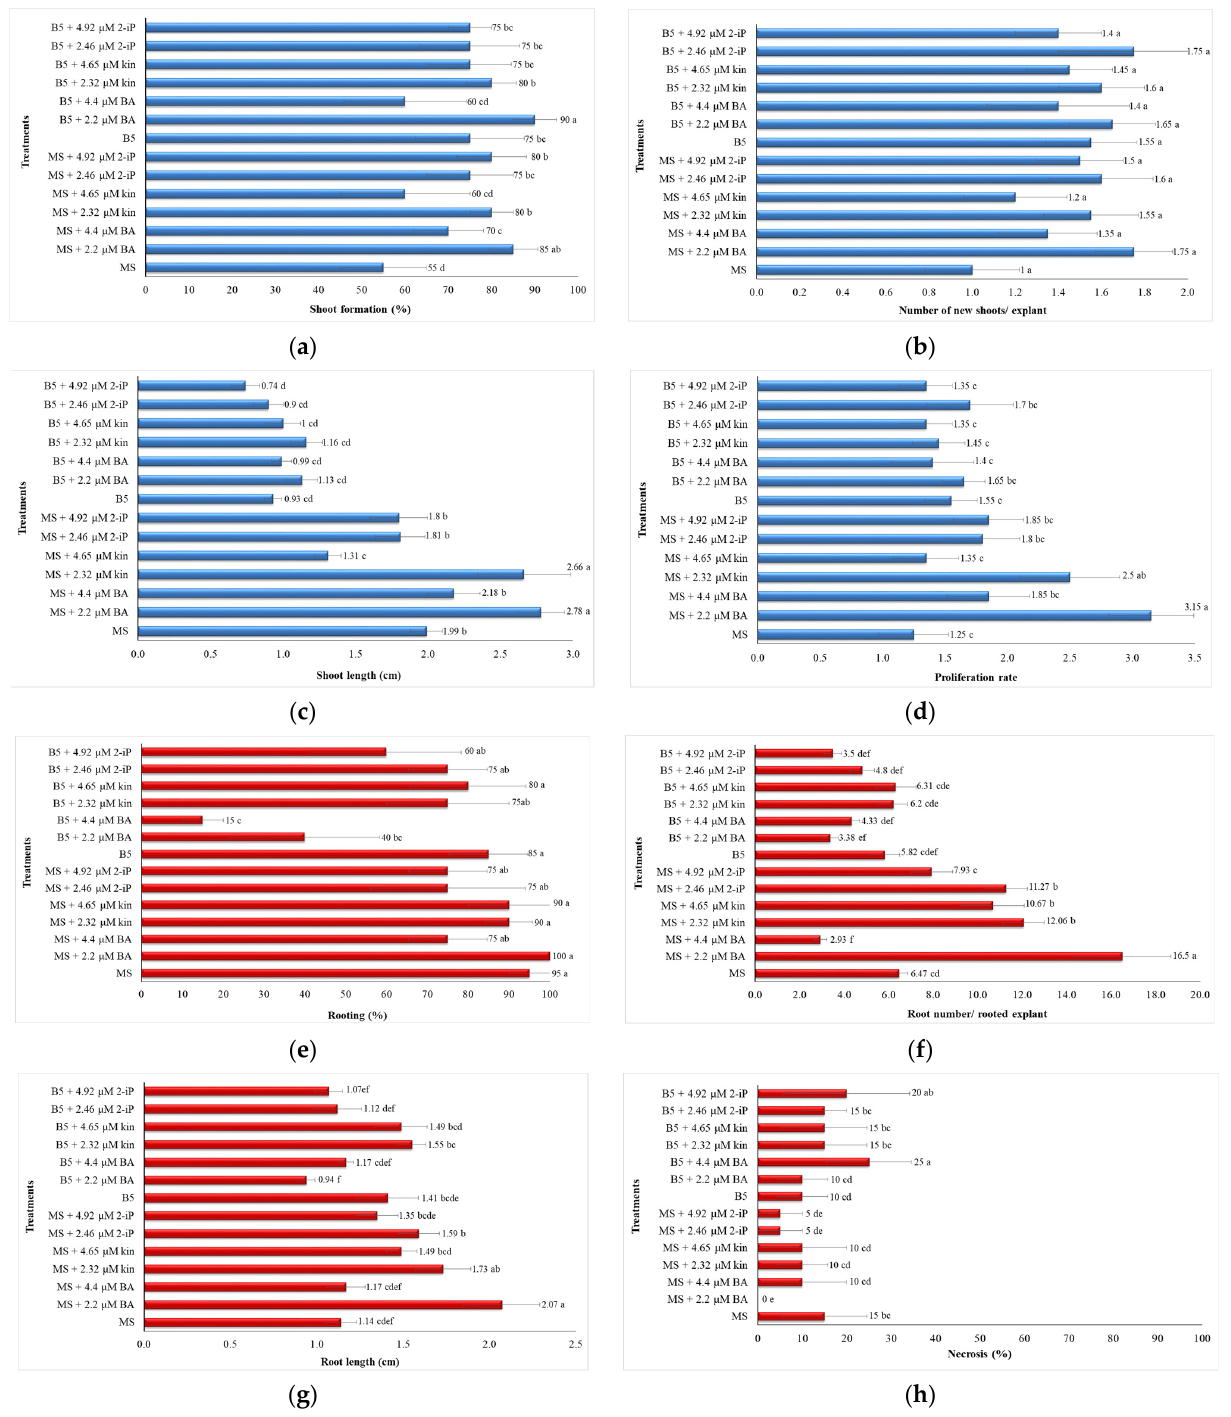
Figure 1. Effect of two basal culture media (MS, B5) supplemented with 0.25 μ M IBA, 0.3 μ M GA 3 , 20 g L − 1 sucrose and 6 g L − 1 Plant Agar (pH: 5.8) in combination with three cytokinin types (BA, Kin, 2-iP) at three concentrations on shoot proliferation and rooting parameters in O. dictamnus explants after 30 days of in vitro culture: ( a ) Shoot formation (%) (graph horizontal scale bar: 1 unit = 10%); ( b ) Number of new shoots/explant (graph horizontal scale bar: 1 unit = 0.2); ( c ) Shoot length (cm) (graph horizontal scale bar: 1 unit = 0.5 cm); ( d ) Proliferation rate (graph horizontal scale bar: 1 unit = 0.5); ( e ) Rooting (%) (graph horizontal scale bar: 1 unit = 10%); ( f ) Root number/rooted explant (graph horizontal scale bar: 1 unit = 2); ( g ) Root length (cm) (graph horizontal scale bar: 1 unit = 0.5 cm); ( h ) Necrosis (%) (graph horizontal scale bar: 1 unit = 10%).